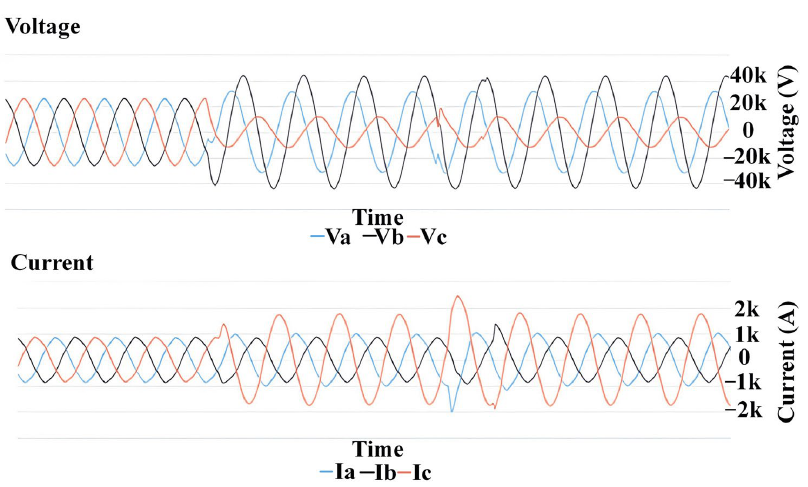
Figure A2. Current and voltage waveform recorded by PQ analyzer during the voltage sag for event 2.